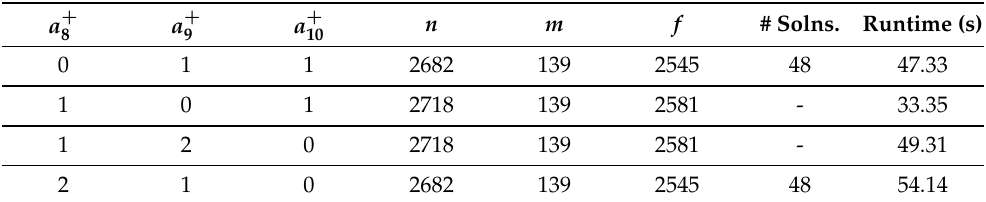
Table 6. Number of tiling solutions (# solns.) and runtimes in seconds for CPLEX to solve the four pariomino tiling subproblems in Example